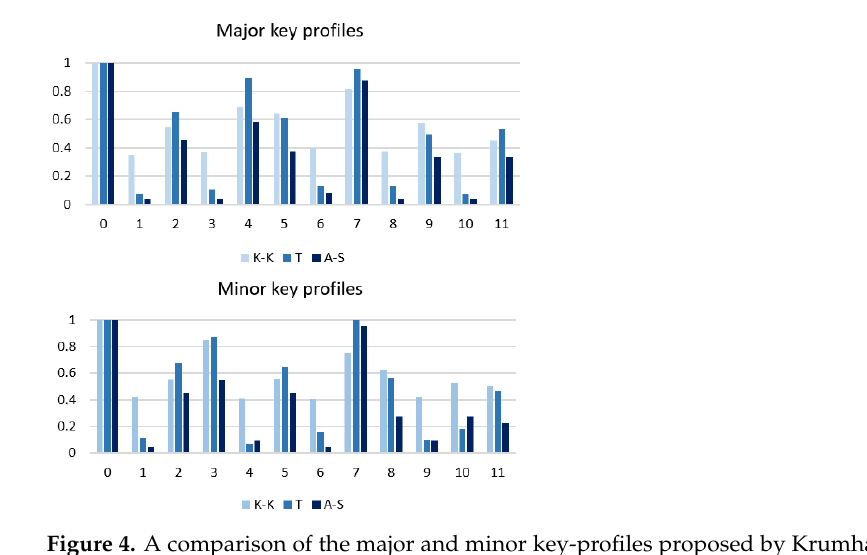
Figure 4. A comparison of the major and minor key-profiles proposed by Krumhansl and Kessler (K-K), Temperley (T), and Albrecht and Shanahan (A-S). Example 2. Finding the key of a music piece based on the signature of fifths .